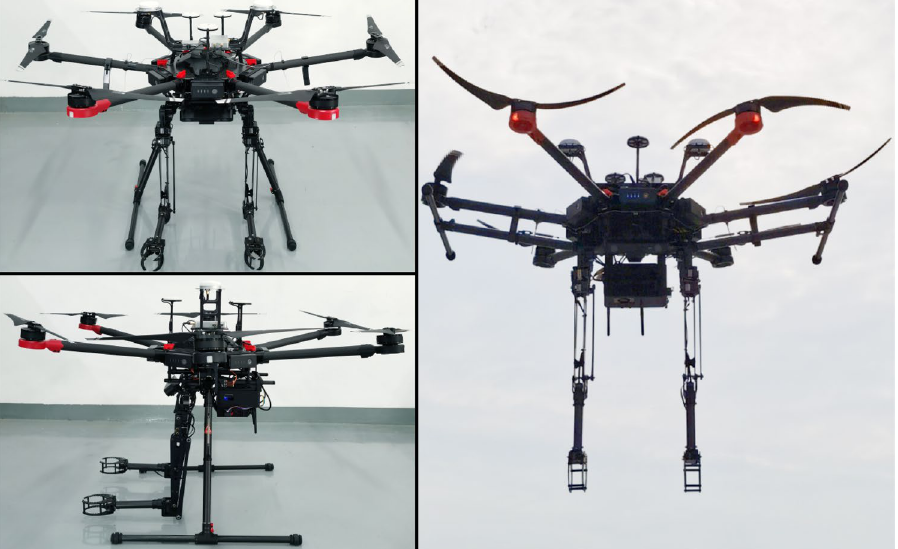
Figure 4. Aerial manipulation system with different views.